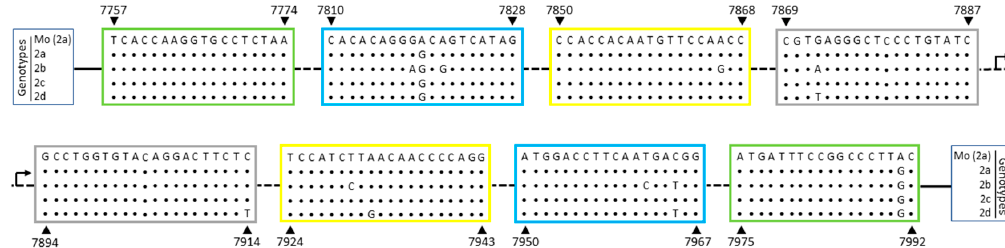
Figure 2. HTLV-2 tax sequence recognized by LAMP primers. HTLV-2 genome sequence corresponding to LAMP primers designed based on the Mo strain (GenBank M10060), HTLV-2a genotype, were aligned with representative sequences of all four HTLV-2 genotypes: 2a, 2b, 2c, and 2d. The nucleotide positions are related to the Mo strain (indicated by arrows) and the regions for primer hybridization are highlighted in boxes: green: F3/B3; blue: F2/B2; yellow: LF/LB; gray: F1c/B1c.